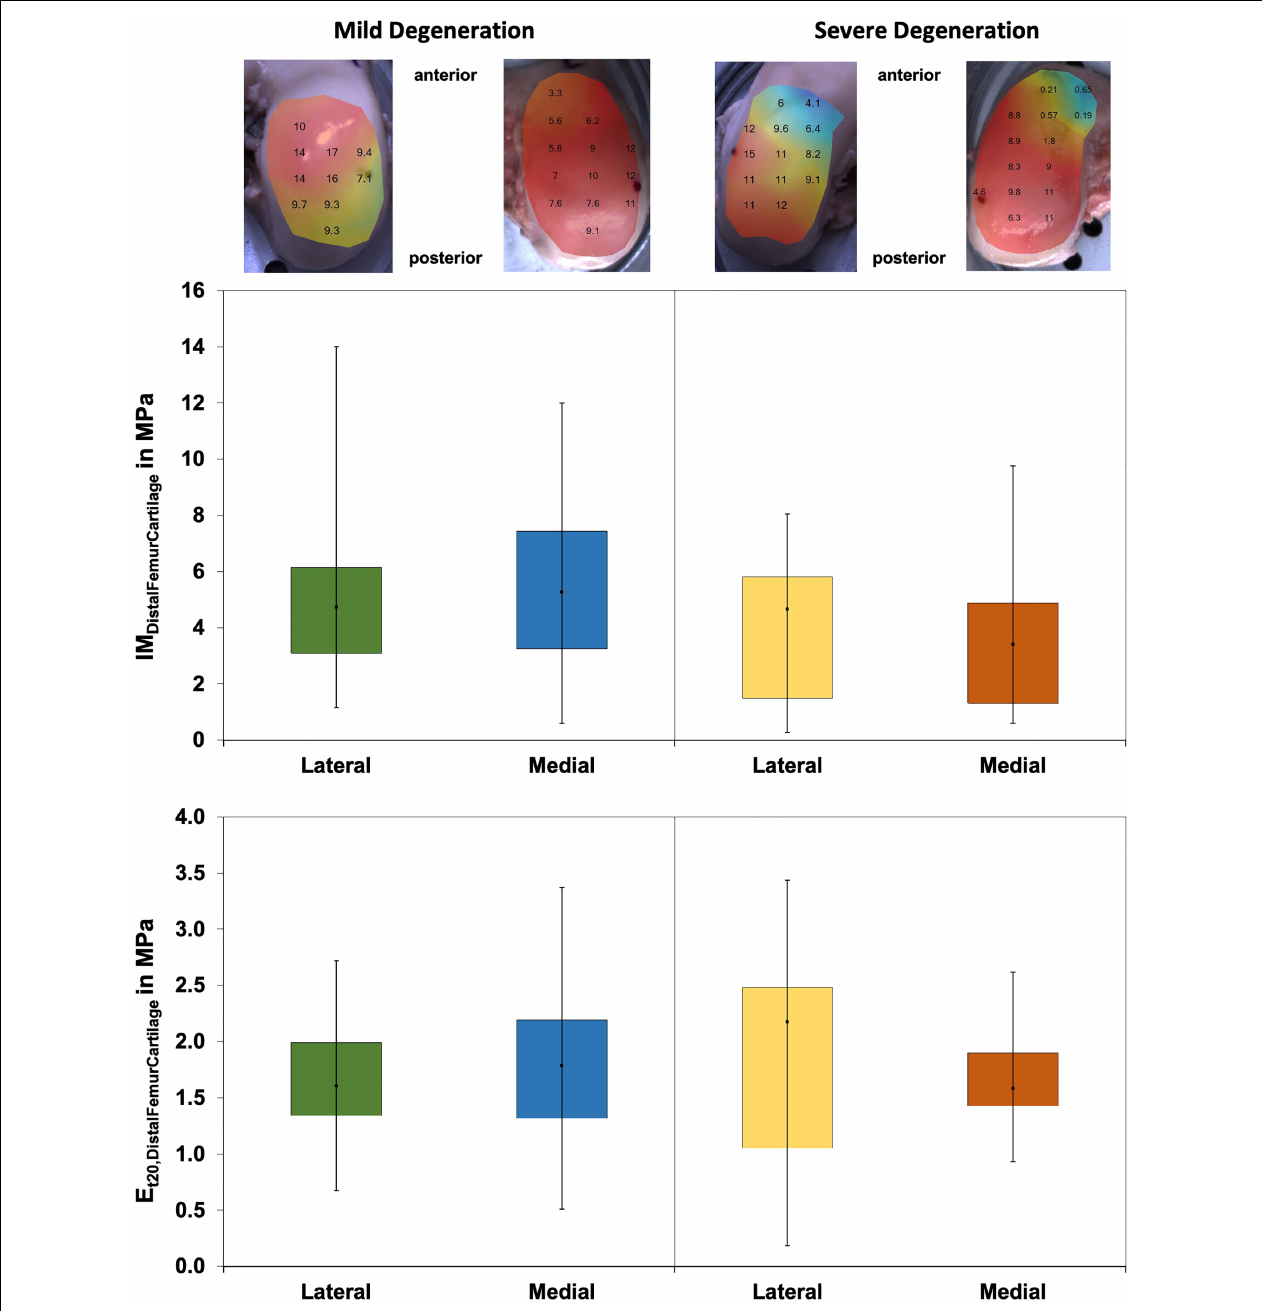
FIGURE 8 | Representative maps of the instantaneous modulus (IM) measurements of the mildly degenerated and severely degenerated distal femora, with all values given in megapascal. Middle row : Box plots (minimum, maximum, median, and 25th and 75th percentiles) of the lateral and medial IM DistalFemurCartilage values in megapascal. Lower row : Box plots (minimum, maximum, median, and 25th and 75th percentiles) of the lateral and medial E t20 values in megapascal. Non-parametric statistical analyses: n =